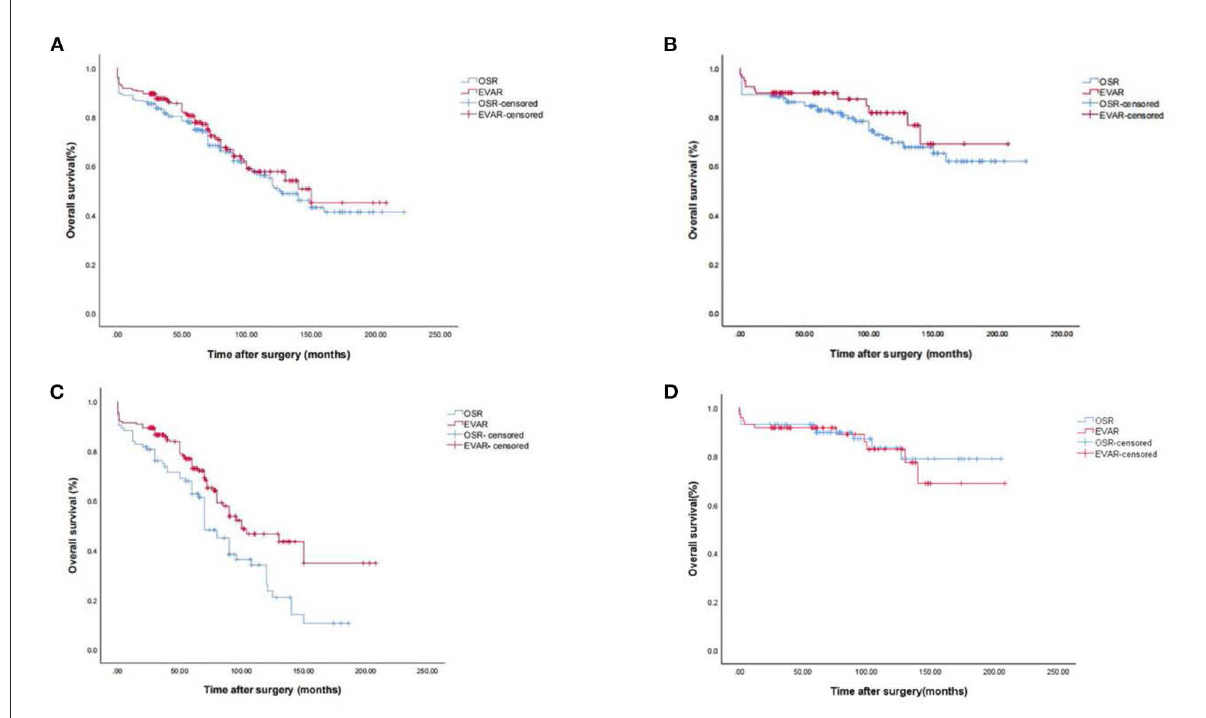
FIGURE1 Kaplan-Meier survival analysis for AAA. (A) Kaplan-Meier survival analysis for AAA. (B) Kaplan-Meier survival analysis for AAA in young and middle-aged group. (C) Kaplan-Meier survival analysis for AAA in elder group. (D) Kaplan-Meier survival analysis for AAA in young and middle-aged group (PSM analysis).